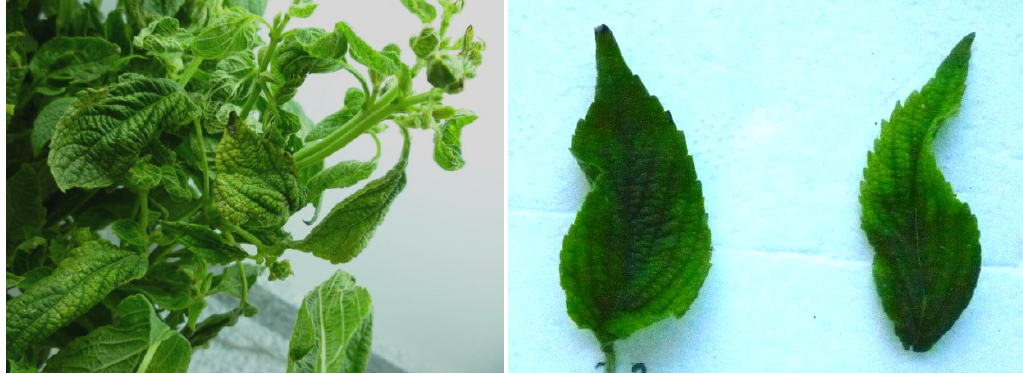
Figure 1. Chia plants showing viral disease symptoms: dwarfism, chlorosis and